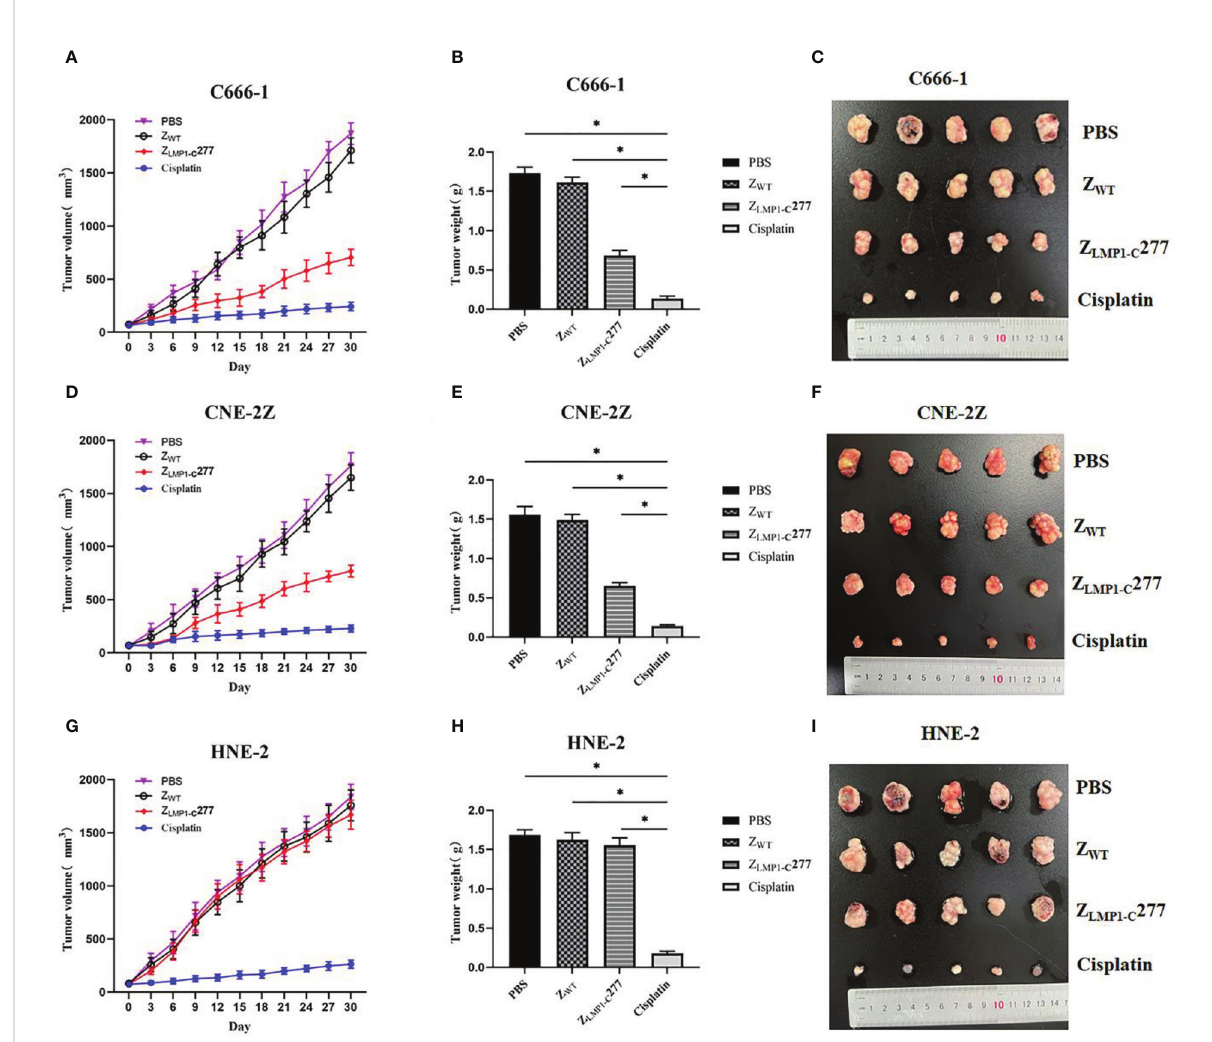
FIGURE 5 In vivo antitumor ef fi cacy of Z LMP1-C 277. (A, D) Tumor volumes of NPC-bearing nude mice after various treatments (PBS, Z WT , Z LMP1-C 277 and cisplatin). (C, F) Photographs of the tumors separated from C666-1 and CNE-2Z mice after different treatments. (G) Tumor volumes (I) tumors separated from mice in HNE-2 group. All tumors from (B) C666-1 (E) CNE-2Z, and (H) HNE-2 were weighed and compared. Data are given as mean ± SD (n=5). *P <0.05 compared to control